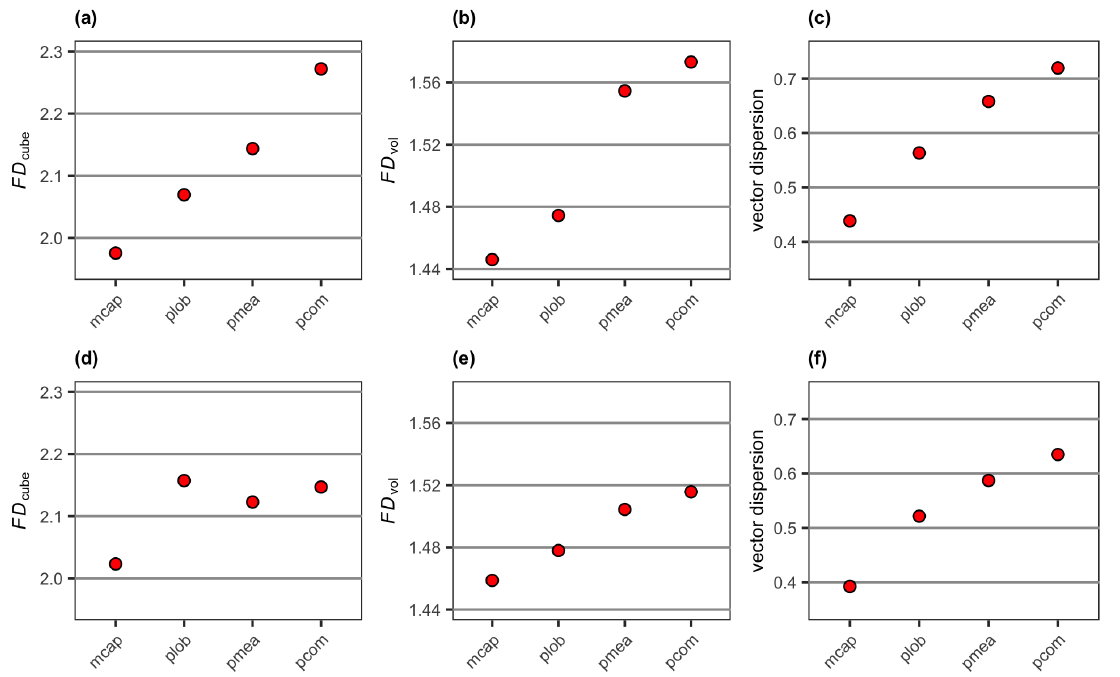
Figure 14. Values of ( a ) FD cube , ( b ) FD vol and ( c ) vector dispersion extracted from the 3D mesh models of the four reconstructed coral colonies with different morphologies, and ( d ) FD cube , ( e ) FD vol and ( f ) vector dispersion extracted from the 3D mesh models of the four reconstructed coral colonies with different morphologies with a substratum: mcap = encrusting M. capitata , plob = mounding P. lobata , pmea = branching P. meandrina and pcom = branching P. compressa